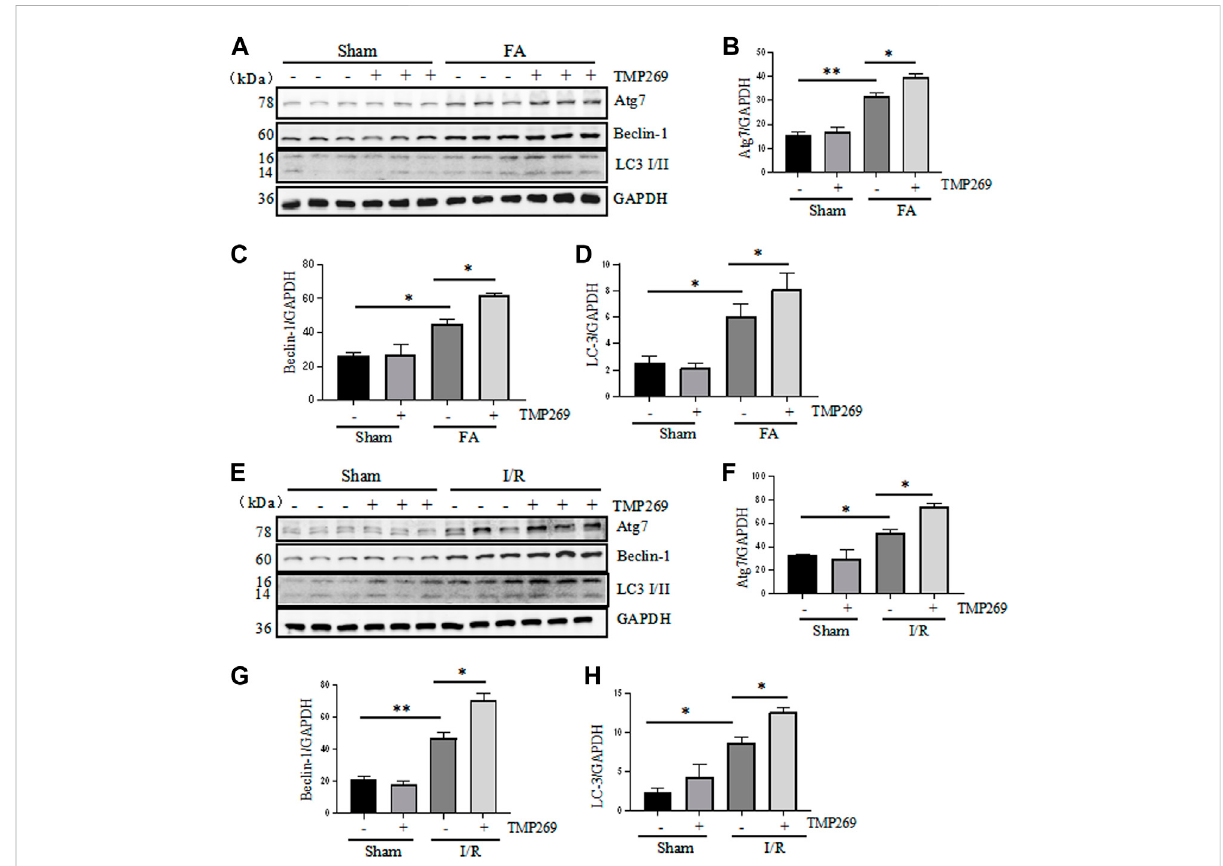
FIGURE 5 AdministrationofTMP269enhancesautophagyinthekidneyfollowingFAandI/Rinjury (A,E) KidneyswereinjuredbyFAorIR,respectively,and tissue lysates were subjected to immunoblot analysis with speci fi c antibodies against Atg7, Beclin-1, LC3, and GAPDH. Representative immunoblots are three samples in each group. Expression levels of Atg7 (B,F) , Beclin-1 (C,G) , or LC3 (D,H) were quanti fi ed by densitometry and normalized with GAPDH. Data are means ± SD ( n = 3). * < 0.05; ** p < 0.01; *** p <